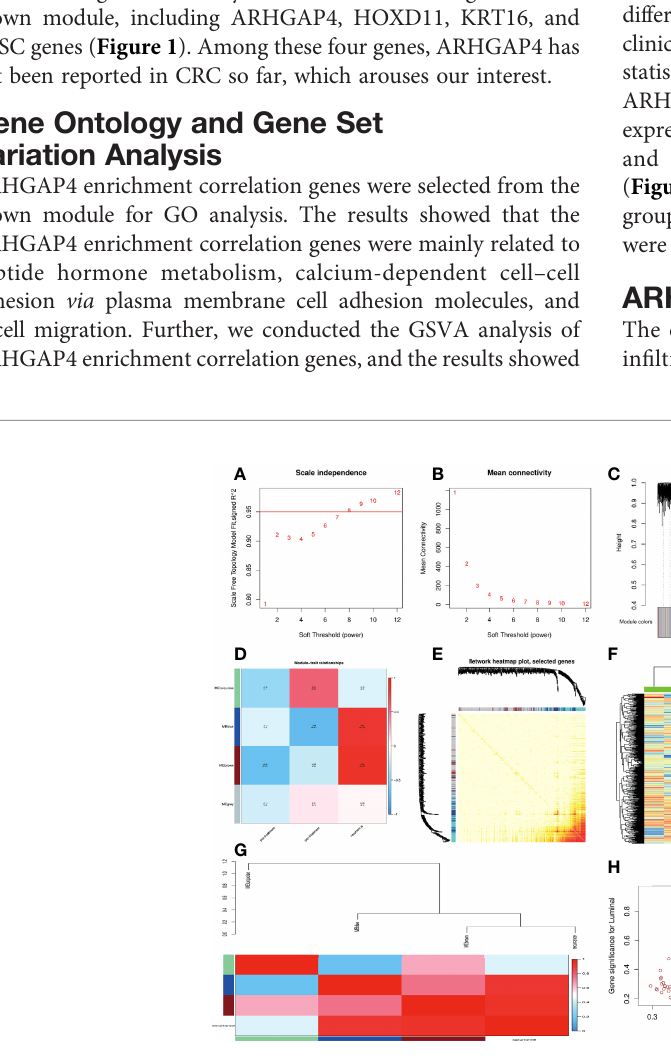
FIGURE 1 | Construction of weighted co-expression network (WGCNA) and WGCNA module analysis. (A, B) Soft threshold selection process: scale independence and mean connectivity. (C) Cluster module dendrogram. Each color represents one speci fi c co-expression module, and branches above represent genes. (D) Heat map of the correlation between clinical traits including pre-treatment, post-treatment, recurrence, and module eigengenes (E) Visualizing gene networks. Select genes for the network heat map plot. (F) Heat map of the correlation between clinical traits and a module. (G) Analysis of the relevancy between blue, brown, gray, and turquoise gene modules and clinical parameters. (H) Correlation between the module membership of modules of interest and gene signi fi cance with clinical traits in the brown module. Four clinically signi fi cant genes with high connectivity were identi fi ed in the brown